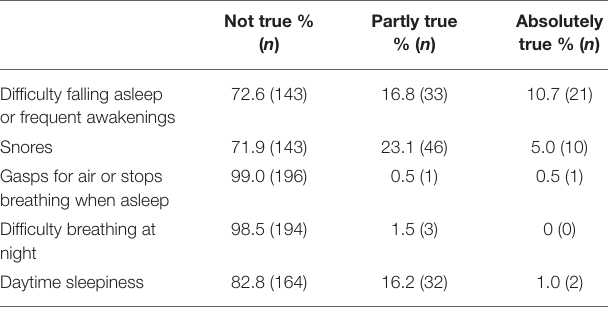
TABLE 2 | Prevalence of parent reported sleep problems at age 11 years in children born extremely preterm a in Norway in